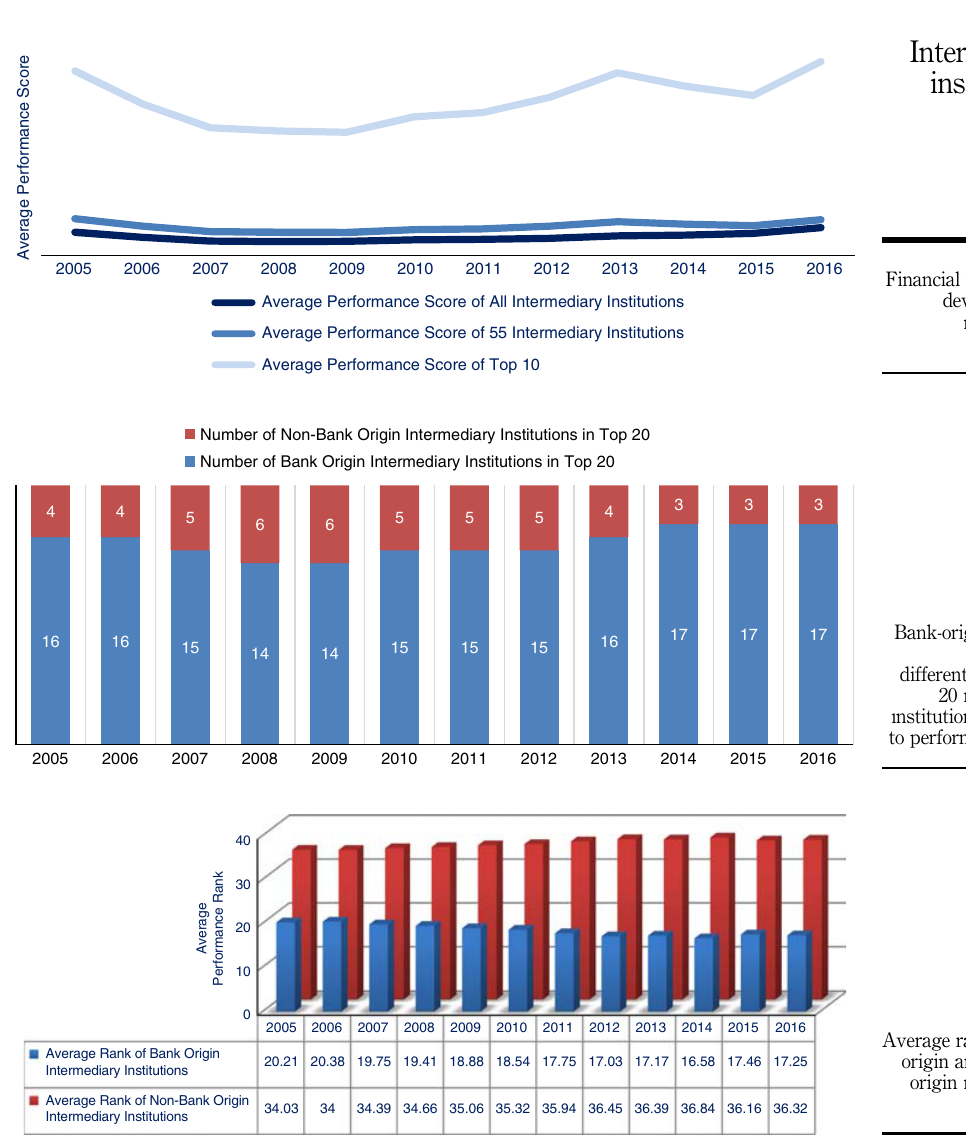
Figure 3. Average rank of bank- origin and non-bank origin ı ntermediary